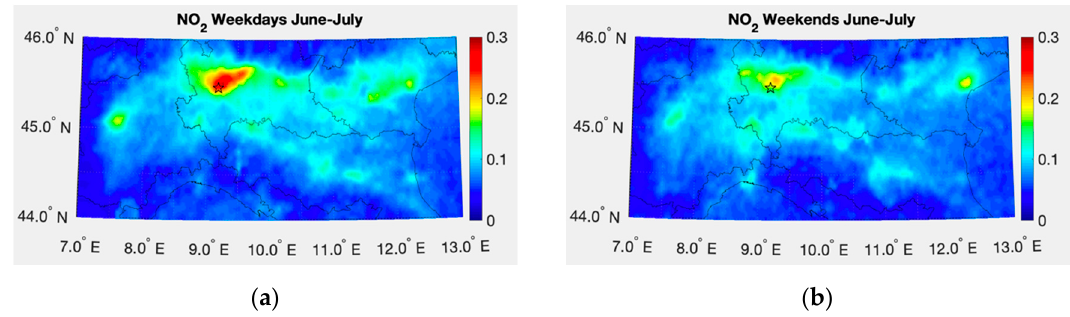
Figure 16. Level 3 NO 2 tropospheric column data over Po Valley for ( a ) 16 weekdays in June-July and ( b ) 16 weekends in the same period. The star indicates the city of Milan.